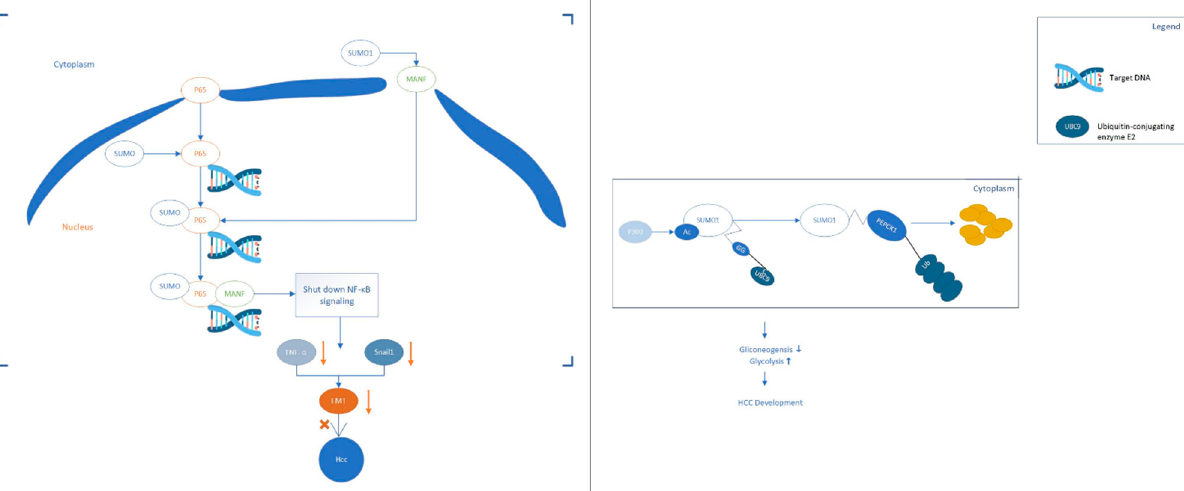
Figure 1. Two examples of SUMO proteins affecting the development process of HCC. ( Left ): SUMO1 binds to MANF and promotes the transfer of MANF to the nucleus. The SUMOylation of P65 can up-regulate the combination of P65 and MANF to form a repressor complex, thereby hindering the transmission of NF- κ B signals. Eventually, the expression of TNF- α and Snails downstream of the NF- κ B signalling pathway is down-regulated, which hinders the progress of HCC. ( Right ):